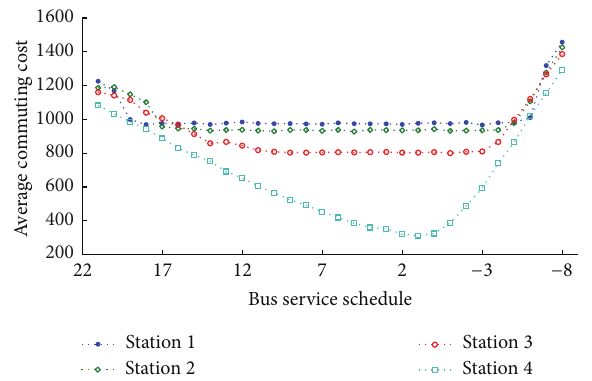
Figure 9: Average commuting cost of commuters on each